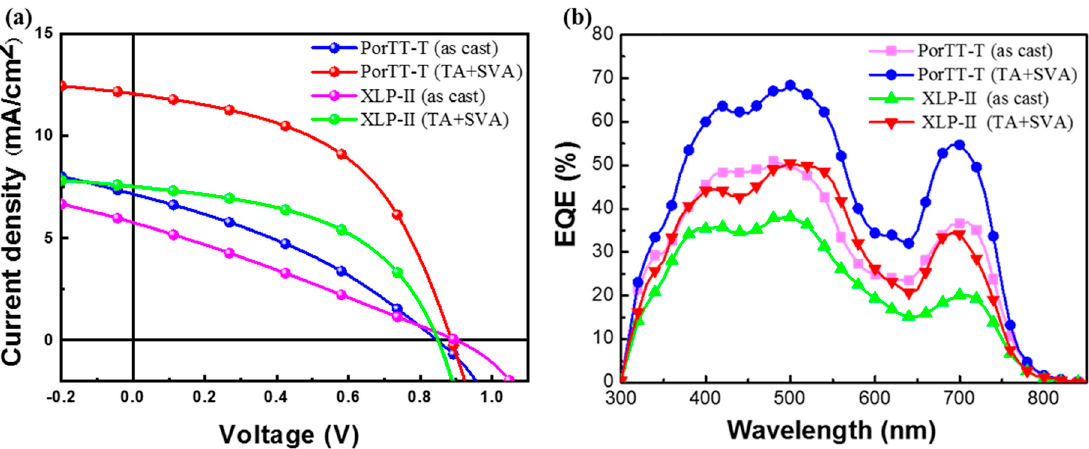
Figure 6. ( a ) Forward scanning current density–voltage (J–V) curves based on without any treatment (as-cast) and with 100 °C annealing for 10 min and CF vapor annealing for another 30s (TA + SVA) PorTT-T and XLP-II. ( b ) EQE spectra of donor (PorTT-T/XLP-II):PC 71 BM blend films in organic semiconductor devices. Table 4. Photovoltaic performance of bulk heterojunction solar cells based on donor (PorTT- T/XLP-II):PC 71 BM with weight ratios of 1:1.2 cast from CB and different post-treatments using PFN-Br/Al and LiF/Ca/Al as the cathode under AM1.5G illumination (100 mW·cm − 2 ).